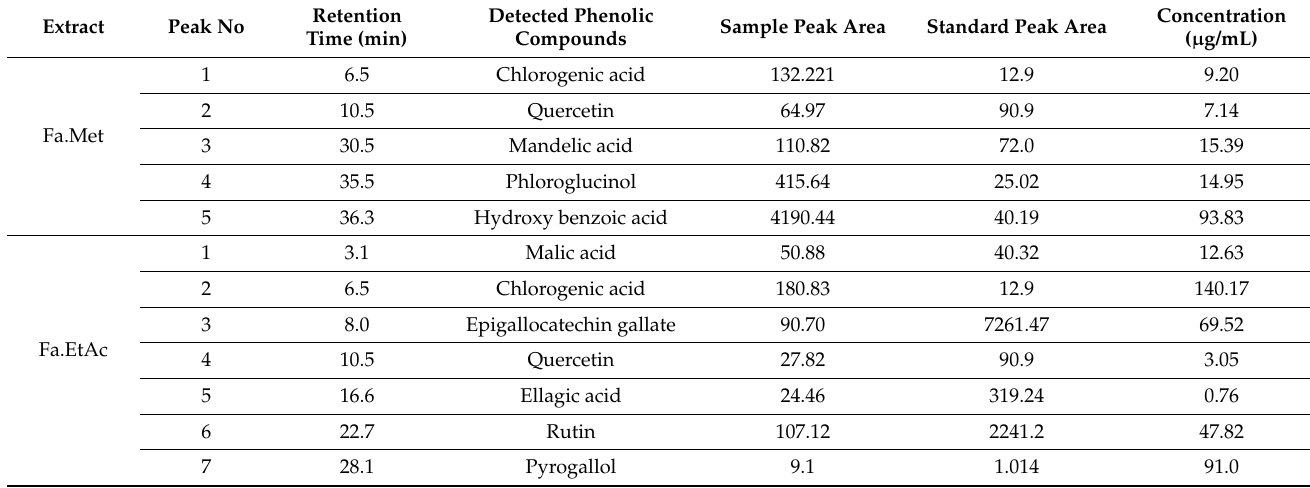
Table 2. Possible compounds identified in Ferula ammoniacum (D. Don) aerial parts extracts. Retention Detected Phenolic Extract Peak No Sample Peak Area Standard Peak Area Time (min) Compounds